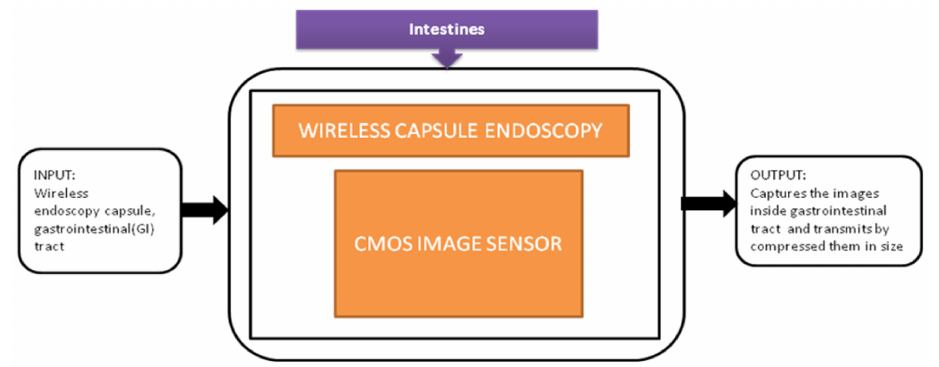
Figure 26. Wireless capsule endoscopy.